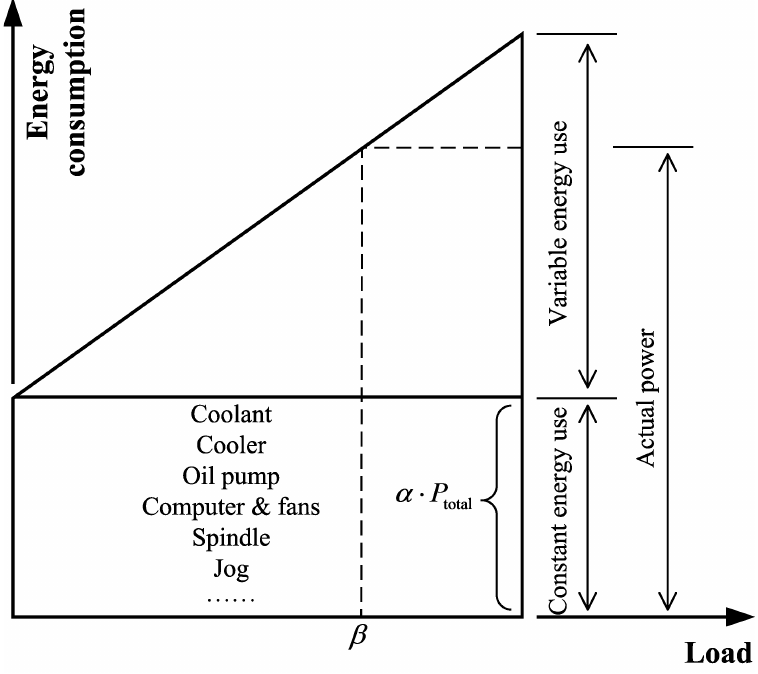
Figure 2. The energy use breakdown of a machine